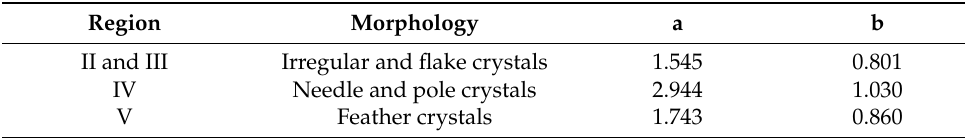
Table 1. The fitting coefficients of Equation (13) and crystal shape for each region.